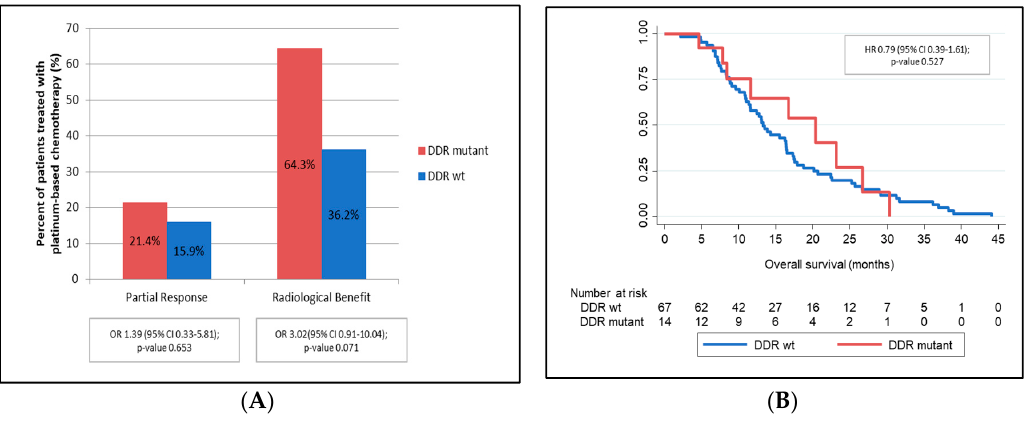
Figure 5. Impact of the presence of DDR gene mutations on outcomes of patients treated with platinum-based chemotherapy. OR: odds ratio; HR: hazard ratio; CI: confidence interval; %: percentage; and wt: wild-type. ( A ): Partial Response and Radiological Benefit; ( B ): Overall survival.